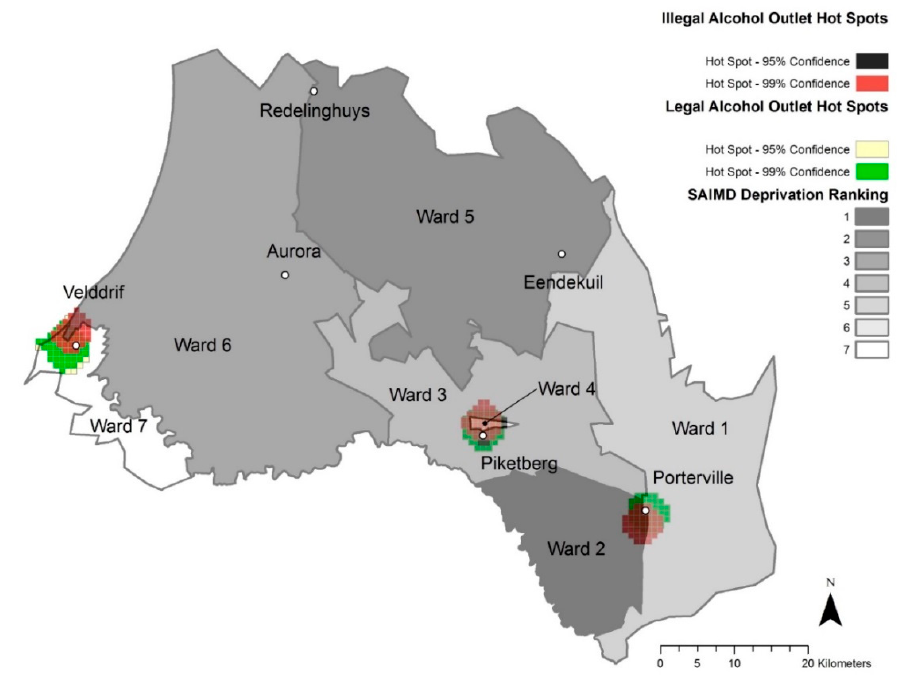
Figure 4. Illegal and Legal Alcohol Outlet Hot Spots, 2016 and Ward Deprivation.